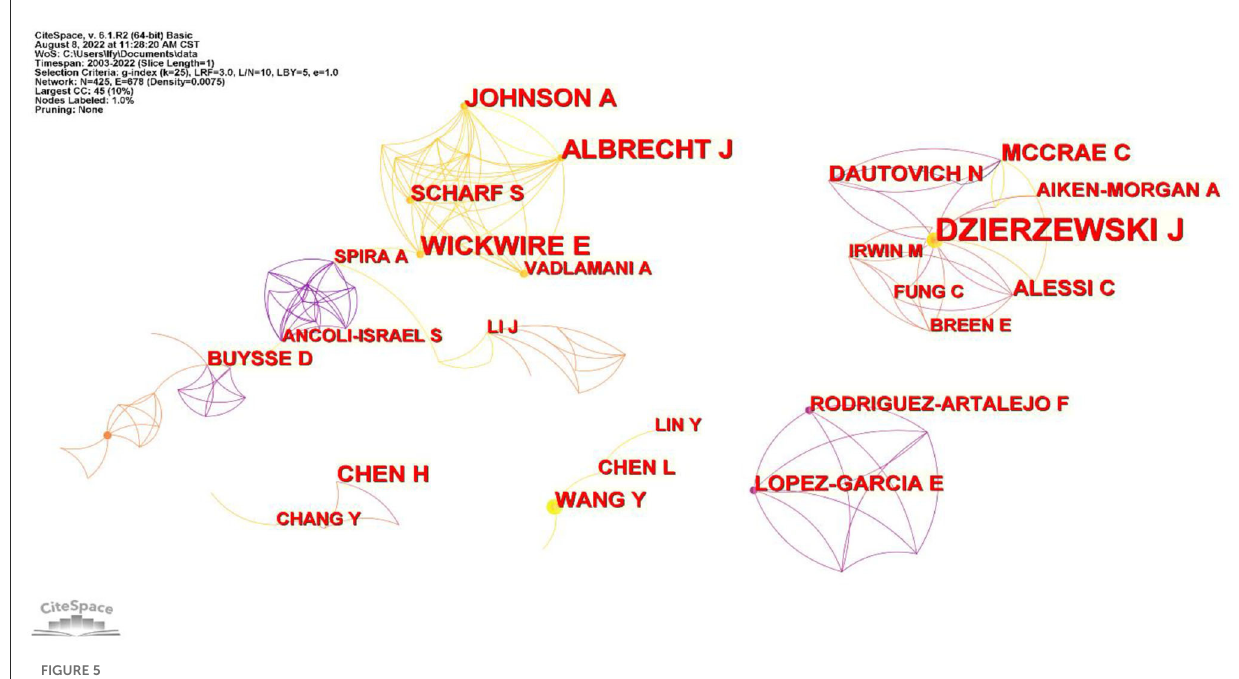
FIGURE5 Author collaboration chart.